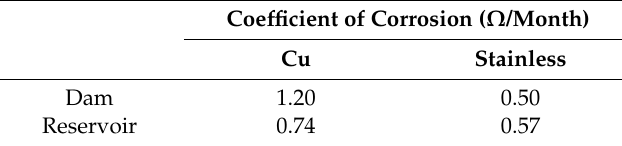
Table 2. Coefficients of corrosion.